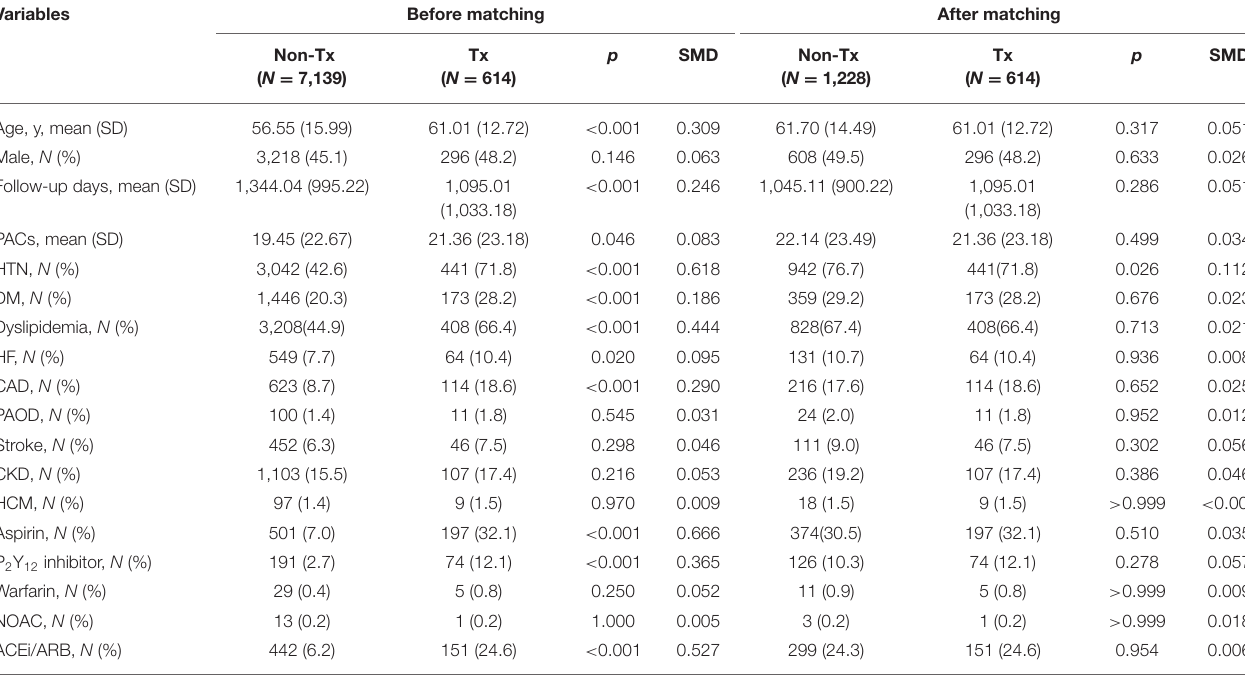
TABLE 2 | Demographic and clinical characteristics of patients with a low burden of PACs in the treatment and non-treatment groups before and after matching. Variables Before matching After